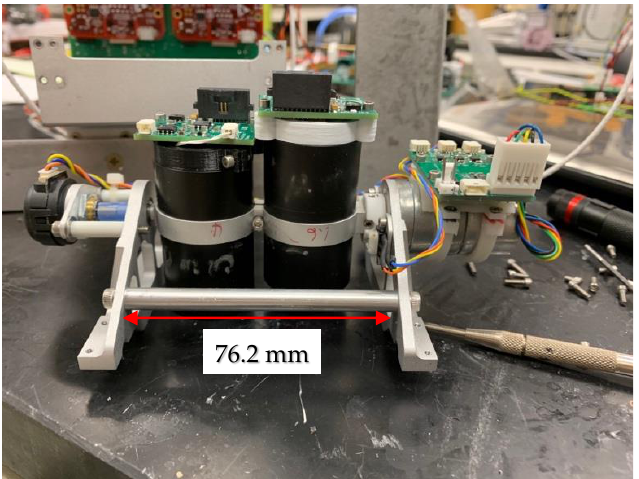
Figure 1. The AWSM two-channel infrared scanner. The sensor telescopes are scanned back and forth across the aircraft flight path, driven by a servo motor ( right side). An angular encoder ( left side) measures the telescope pointing angle relative to aircraft nadir.